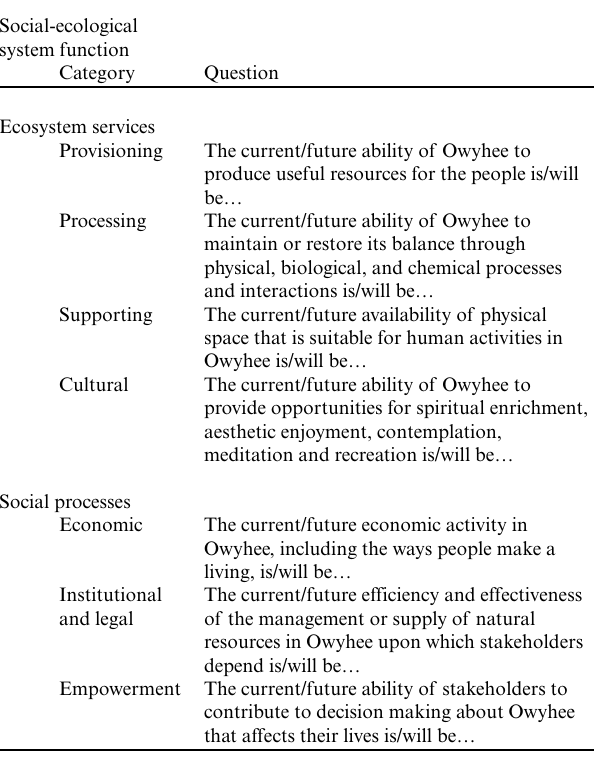
Table 1. Questions used to evaluate participants’ opinions about ecosystem service social